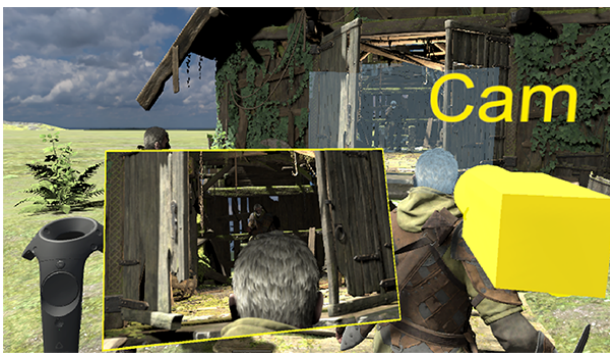
Figure 2. Camera prototype with yellow virtual camera (right). View finder is attached to left controller (left).